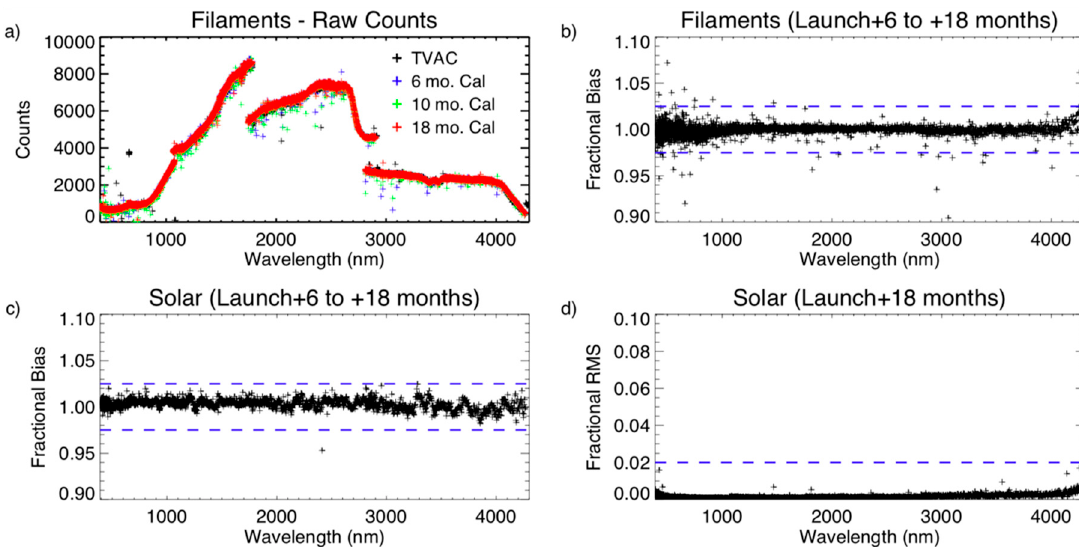
Figure 3. OVIRS radiometric stability and signal-to-noise ratio (SNR) performance from thermal vacuum (TVAC) and flight data. ( a ) Filament spectra from TVAC are identical to flight spectra (colored points), and improvements have been made in bad pixel identification. The fractional bias for the ( b ) filaments and ( c ) solar spectra from observations taken at launch + 6 and + 18 months show stability to within ±1% (dashed lines show the ±2.5% requirement). ( d ) The fractional root mean square (RMS) within the L + 18-month solar spectra indicate that the signal to noise ratio is ~100, better than the required SNR = 50 (dashed line).